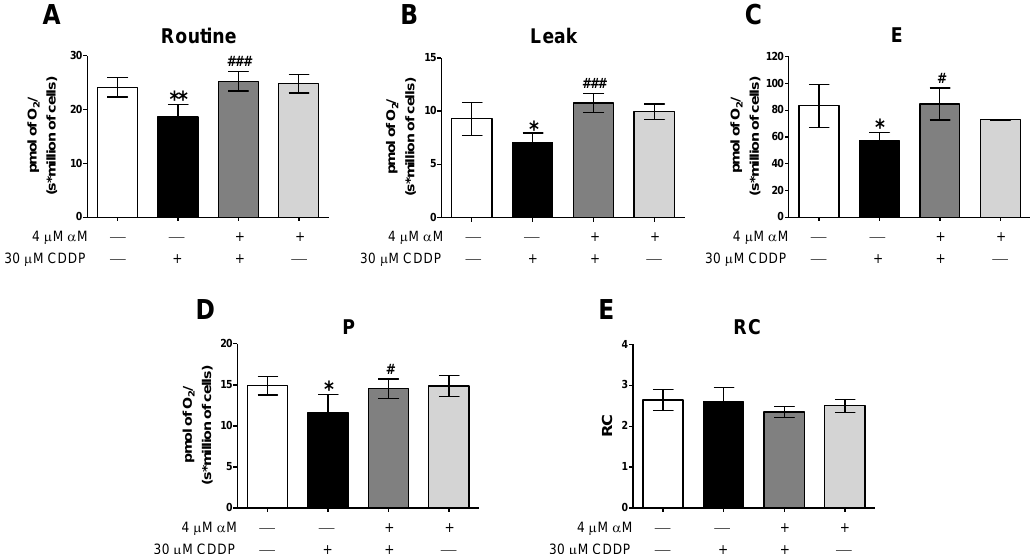
Figure 3. α M co-treatment prevents CDDP induced a decrease in respiratory parameters at 24 h. ( A ) Cellular routine respiration = Routine, ( B ) leak of respiration, ( C ) maximum capacity of electron transfer system = E, ( D ) respiration associated to oxidative phosphorylation = P, ( E ) respiratory control = RC. The data are presented as mean ± SD, n = 3–5. ** p < 0.01 and * p < 0.05 vs. control. ### p < 0.001 and # p < 0.05 vs. CDDP.